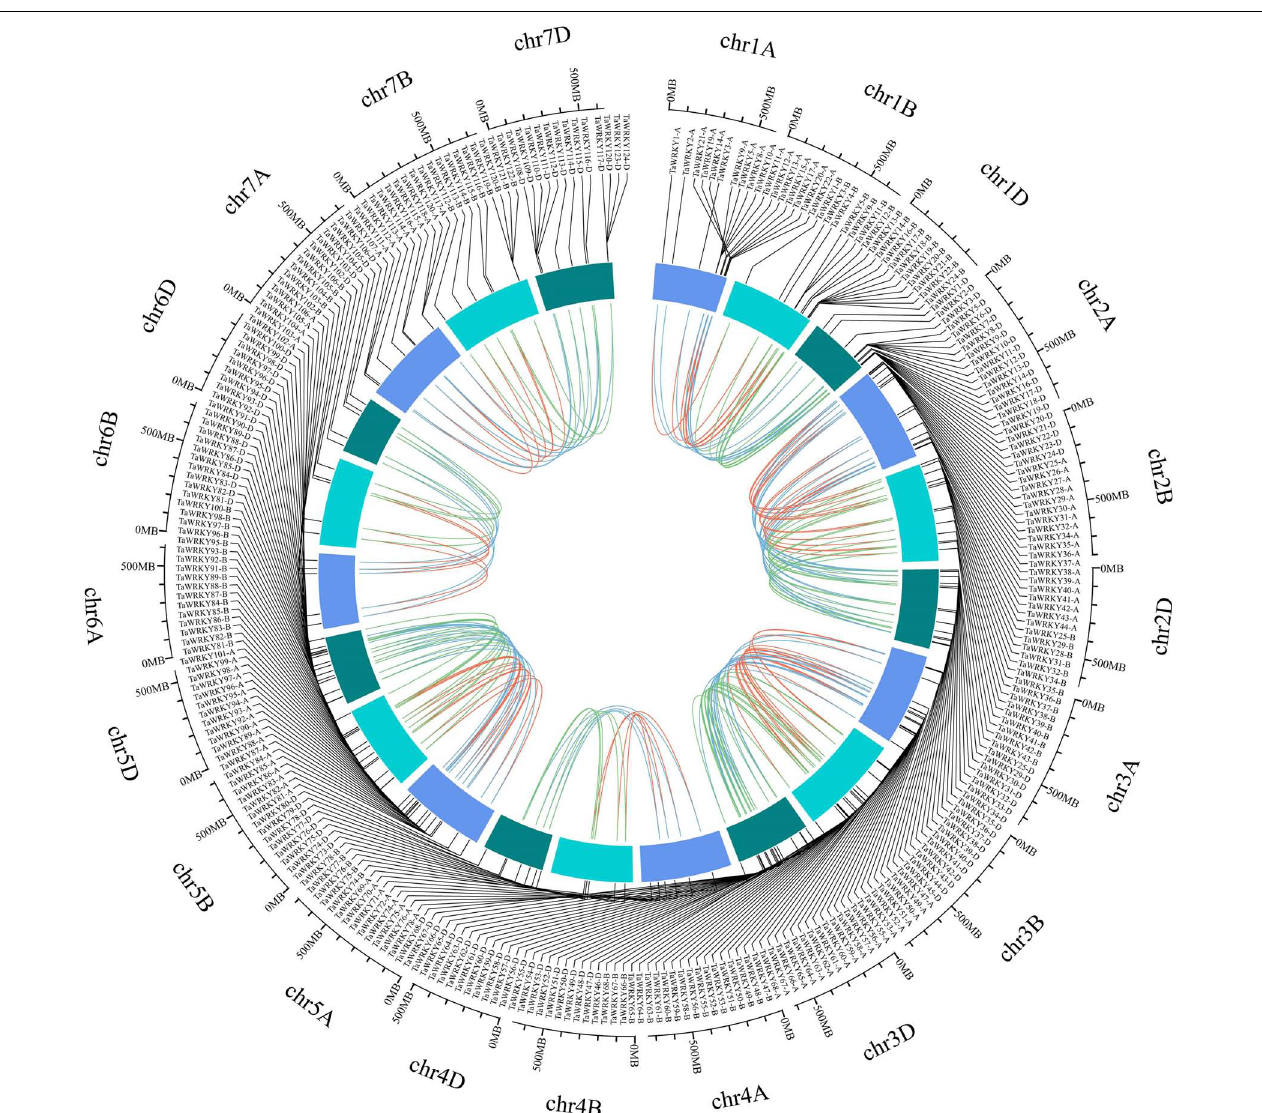
FIGURE 2 | Chromosomal location of TaWRKY genes. All TaWRKY homeologous copies are mapped to their respective locus in wheat chromosomes in a circular diagram. Subgenomes are denoted by different shades of blue. Homeologous genes were inferred by phylogeny and linked with subgenome-specific colors: subgenome A, red; subgenome B, green; subgenome D, blue (inside of circle).